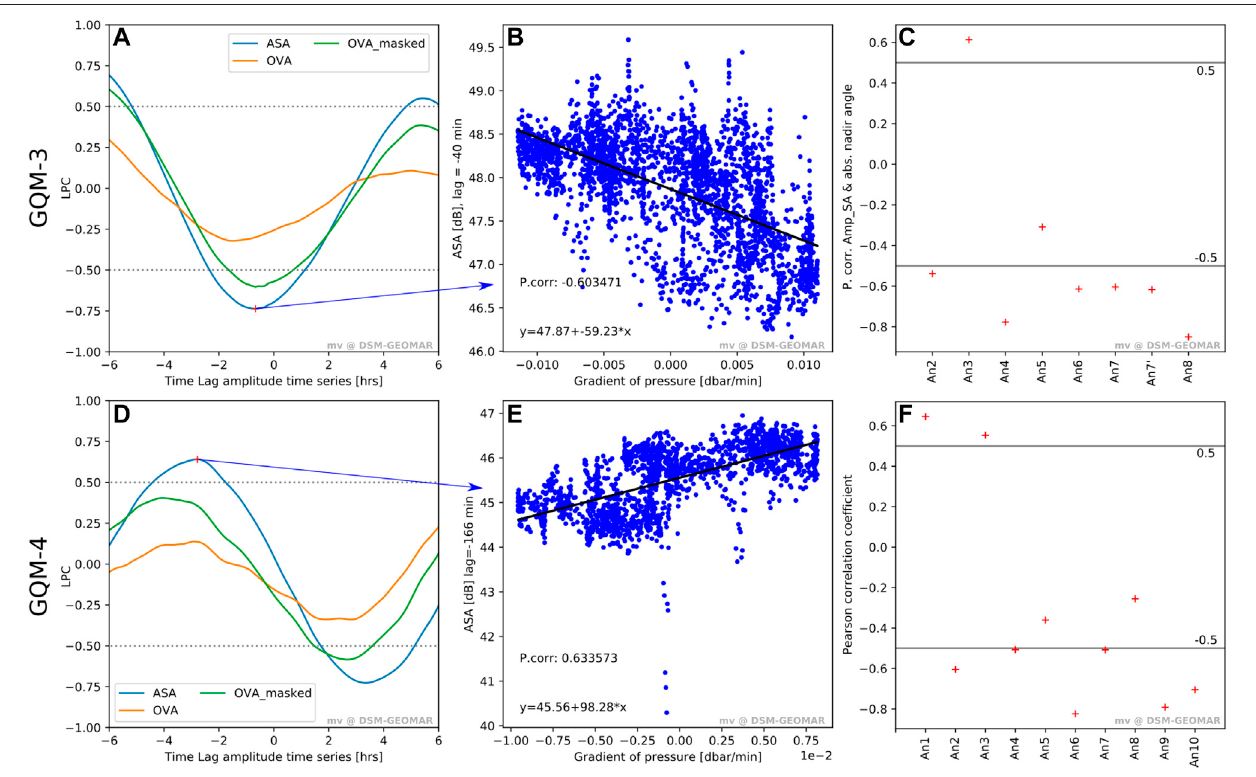
FIGURE 8 | Correlation analyses for overall amplitudes and acoustic anomalies detected in GQM-3 and GQM-4. (A,D) are results from the lagged Pearson correlation (LPC) between time-series of the gradient of the static pressure and overall amplitudes (OVA, OVA-masked, and ASA) associated with bubble release for GQM-3 and GQM-4, respectively. (B,E) are examples of the negative and positive lagged correlation maxima for ASA time-series for GQM-3 and GQM-4, respectively. (C,F) is the Pearson correlation between each single anomaly related to gas seepage and their angle from the MBES-nadir for GQM-3 and GQM-4,